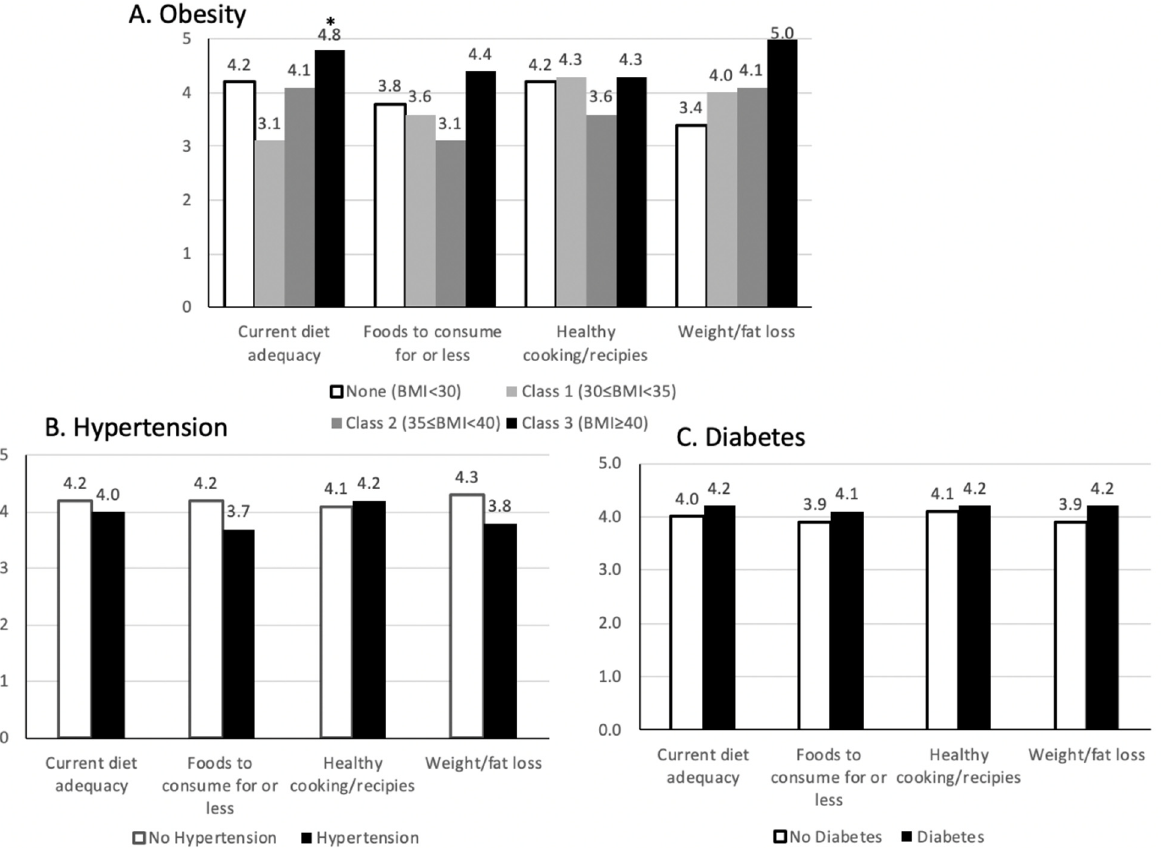
Figure 2. Participant ( n = 83) interest in learning about healthy eating topics. Participant disease status: ( A ) Obesity, ( B ) hypertension, ( C ) diabetes. Y -axis scale indicates participant interest in learning about the topics listed on the x -axis. 0 translates to “not-interested”, and 5 translates to “very interested”. * Indicates statistical significance using Wilcoxon rank-sum and Kruskal–Wallis tests ( p <